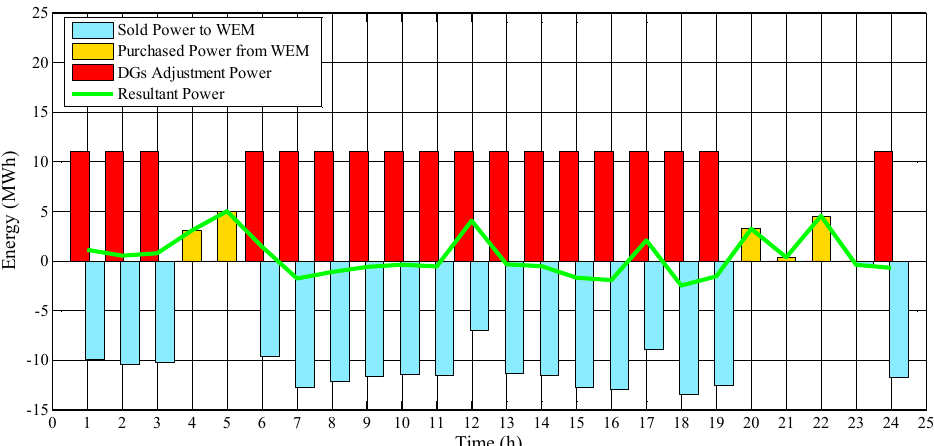
Figure 20. DSO’s traded energy in the RT markets for scenario 6 without considering the competitive environment.